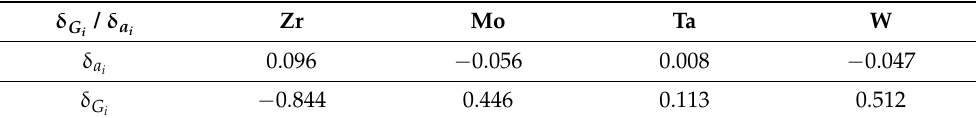
Table 9. Calculated lattice distortion δ G lattice of the ZrMoTaW